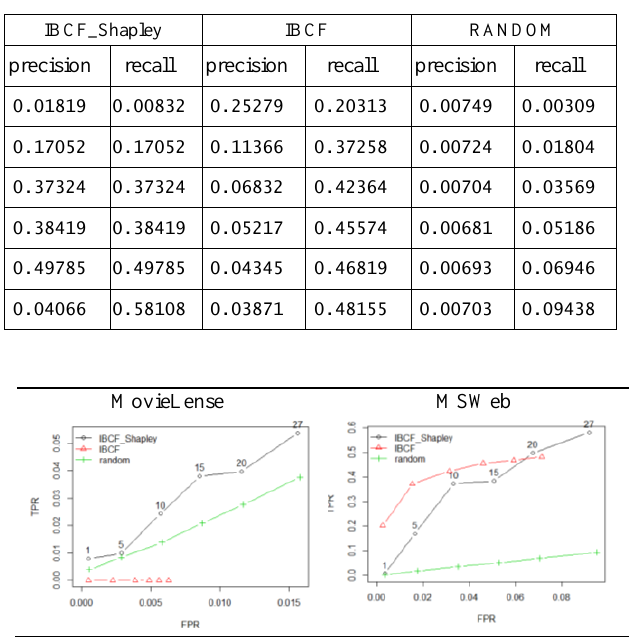
Table 8. The values of precision/recall of three models on